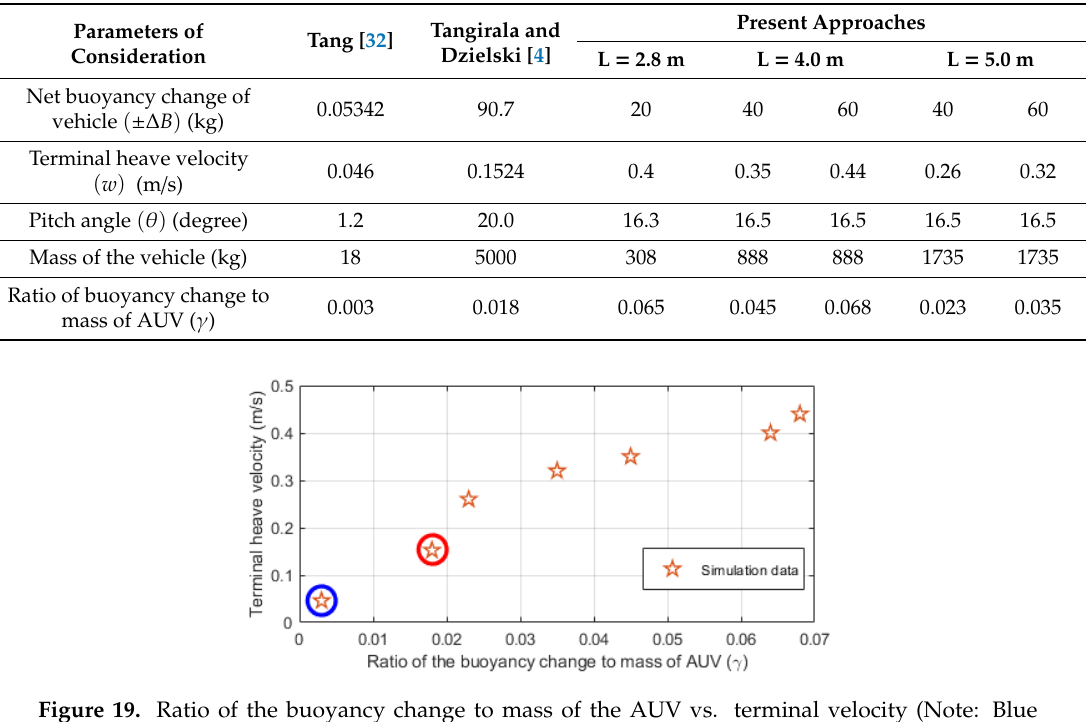
Table 8. Comparative study between some existing model and proposed.